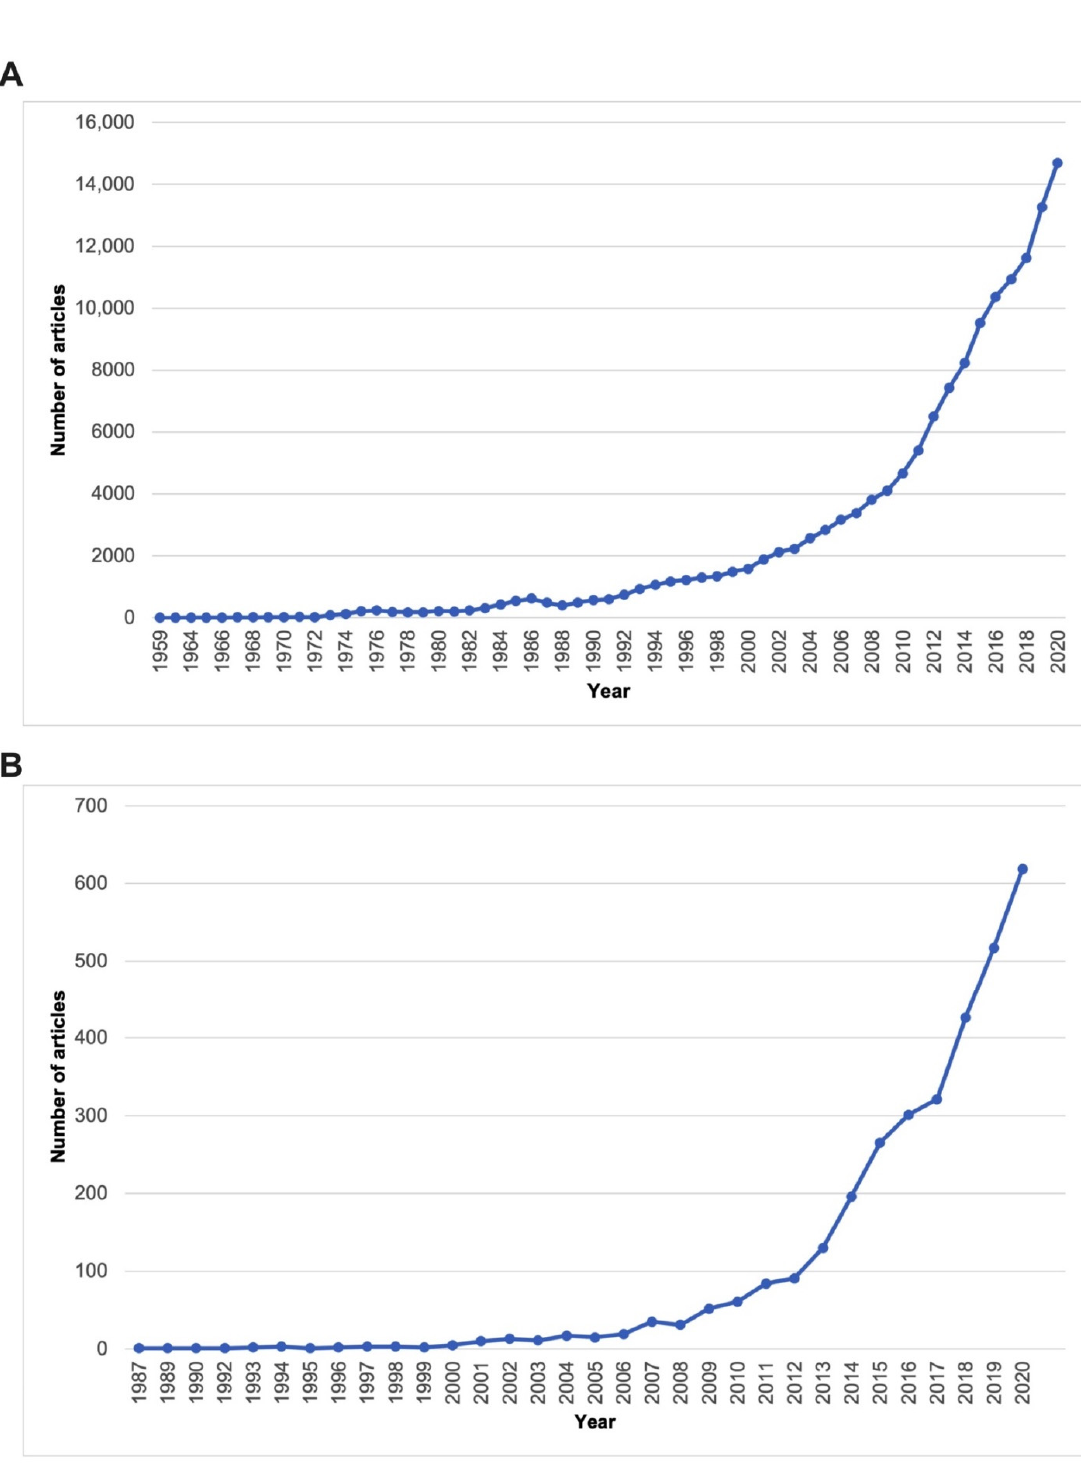
Figure 1. Expansion in the numbers of peer-reviewed published articles with the term “in vitro tumor models” ( A ) or “3D in vitro tumor models ( B ) (source: Scopus; Accessed over time, most recently 17 November 2021).